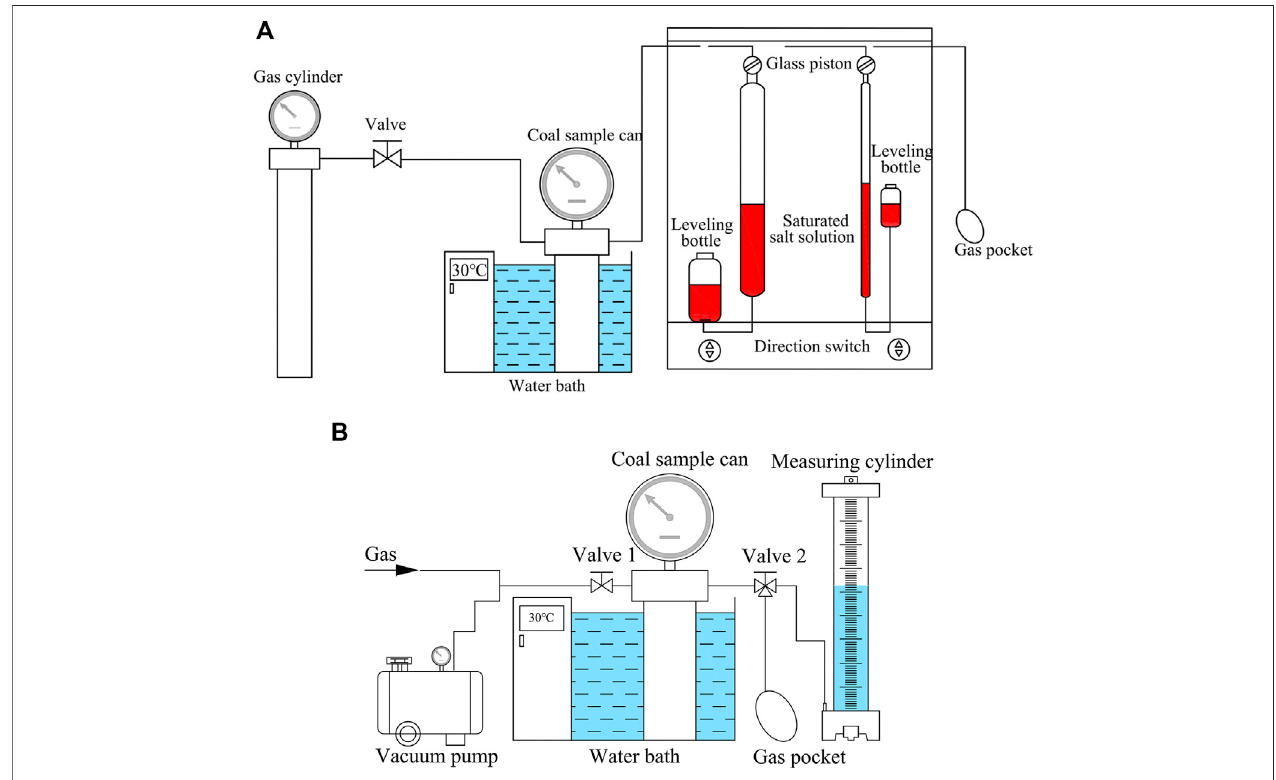
FIGURE 1 | Schematic of the gas adsorption/desorption experimental devices. (A) HCA gas adsorption experimental device. (B) FM-1 gas isothermal desorption device.